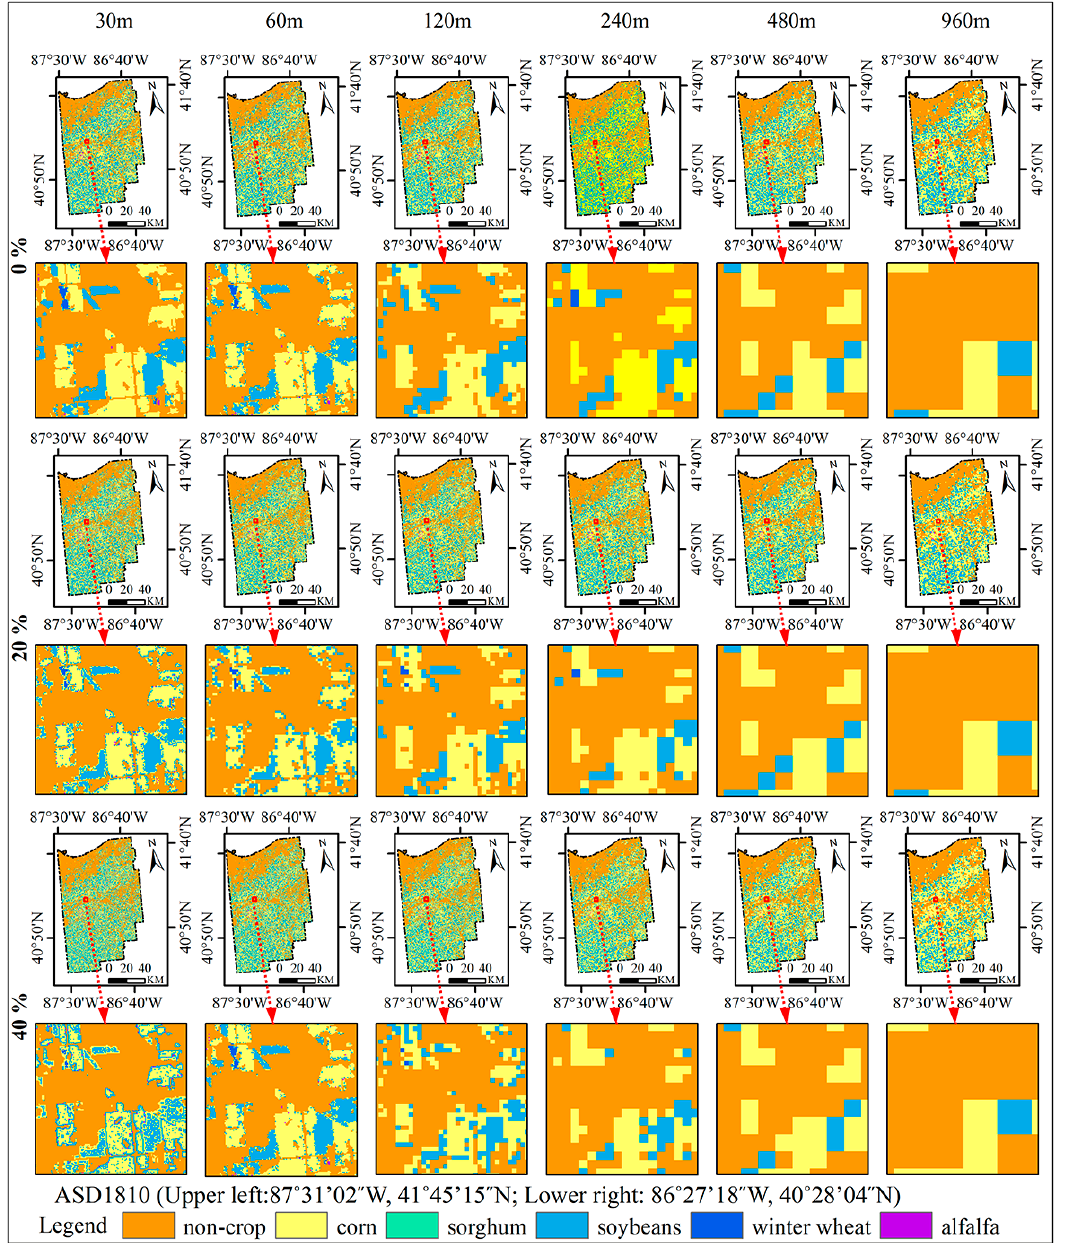
Figure 5. Unscaled maps for ASD1810 at selected resolutions and error levels. Each column represents a map with different resolution. Each row represents the results of upscaling with different error levels.